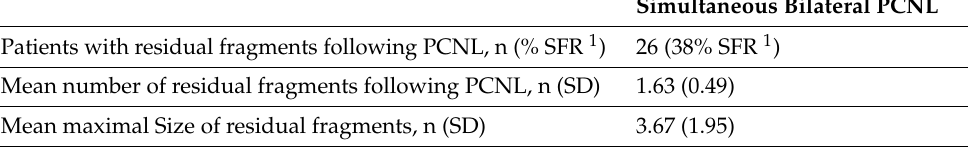
Table 3. Residual fragments